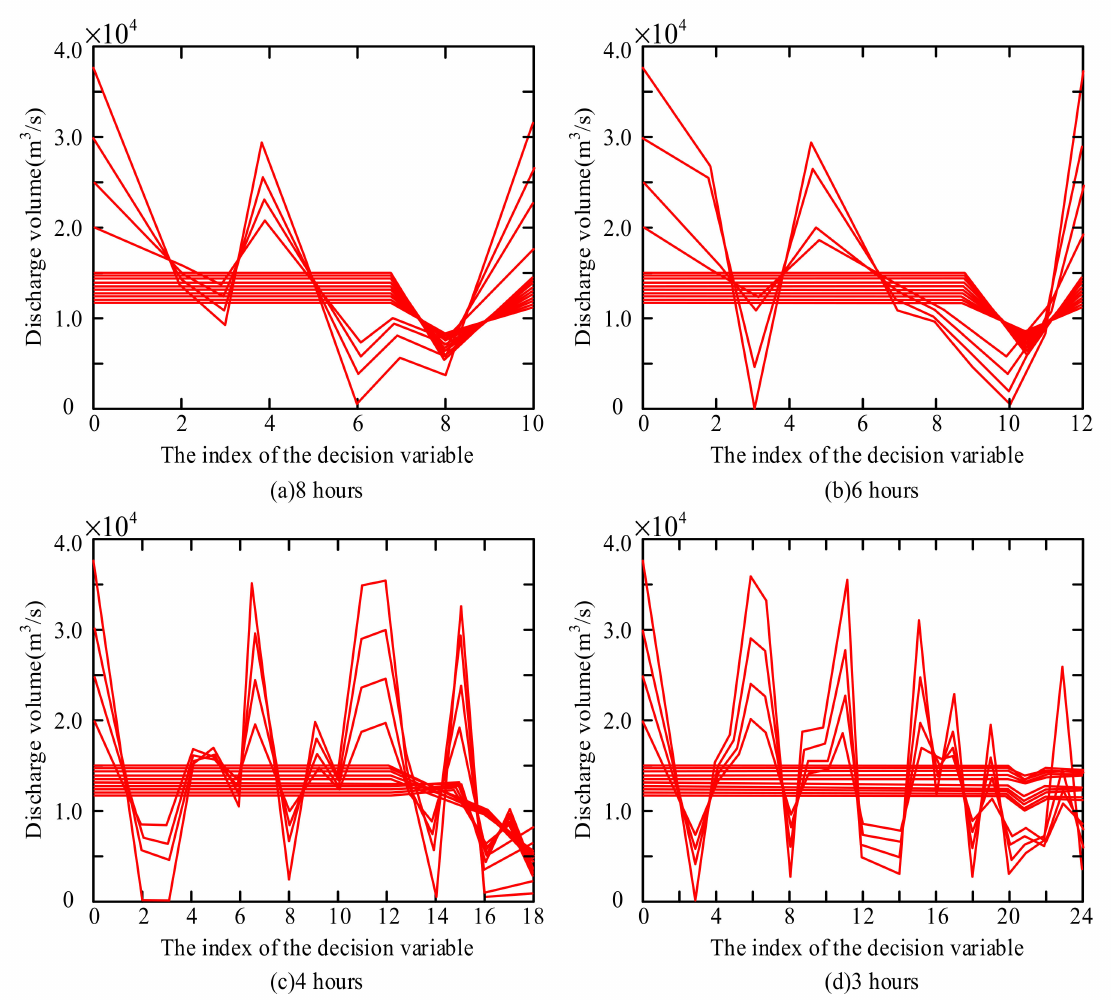
Figure 7. The sequence diagram of optimal drainage flow obtained when the dispatching interval is 8 h, 6 h, 4 h and 3 h